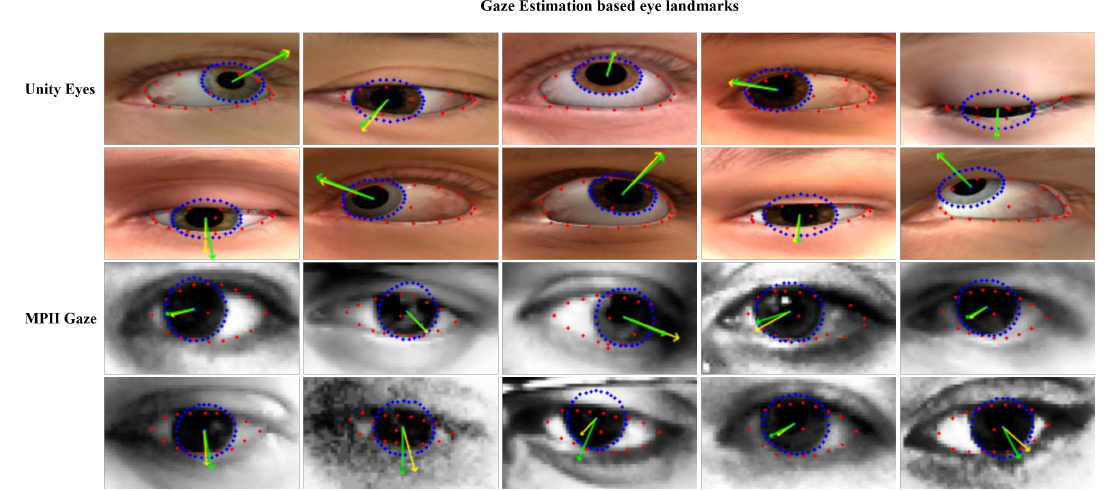
Figure 11. Results of our gaze estimation system with respect to UnityEyes and MPIIGaze test sets. The red, blue points represent the iris edge and the eye edges, respectively. Ground-truth gaze is represented by green arrows and predicted gaze is represented by yellow